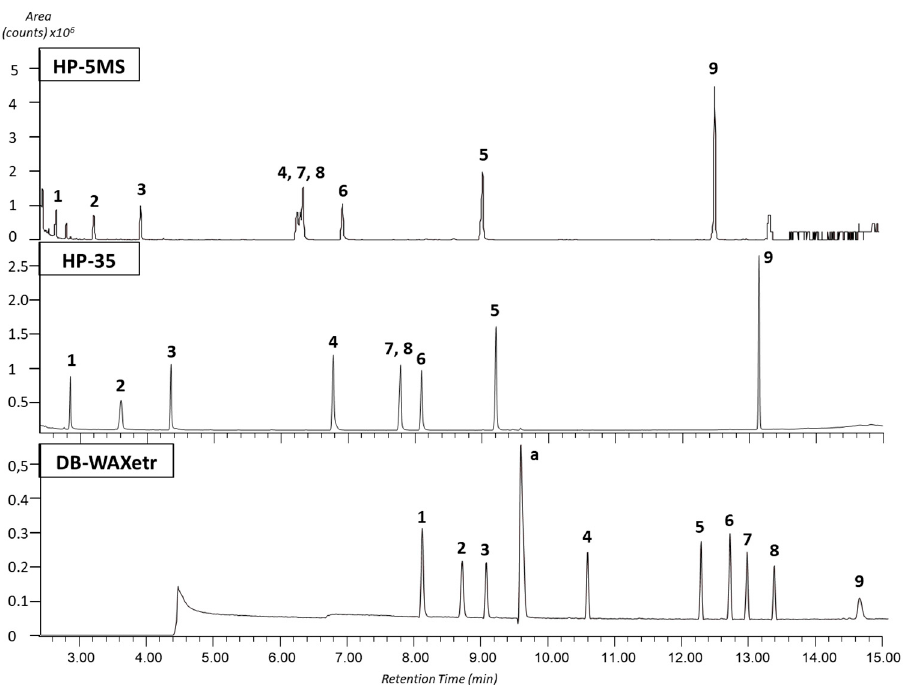
Figure 1. Total ion chromatograms obtained for the 3 tested capillary columns: (1) N-nitrosodimethylamine (NDMA), (2) N-nitrosomethylethylamine (NMEA), (3) N-nitrosodiethylamine (NDEA), (4) N-nitrosodipropylamine (NDPA), (5) N-nitrosodibutylamine (NDBA), (6) N-nitrosopiperidine (NPIP), (7) N-nitrosopyrrolidine (NPYR), (8) N-nitrosomorpholine (NMOR), (9) N-nitrosodiphenylamine (NDPhA), (a) column bleed.